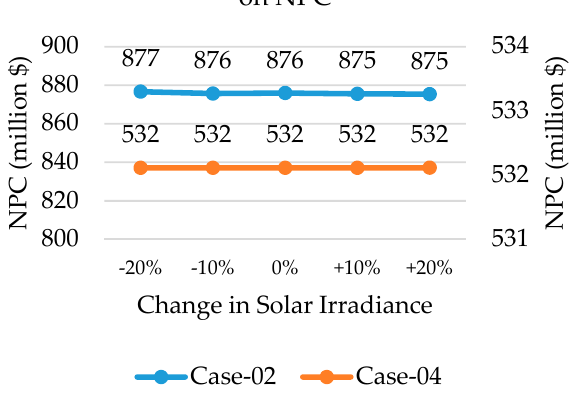
Figure 18. Sensitivity Assessment of Solar Irradiance on NPC.